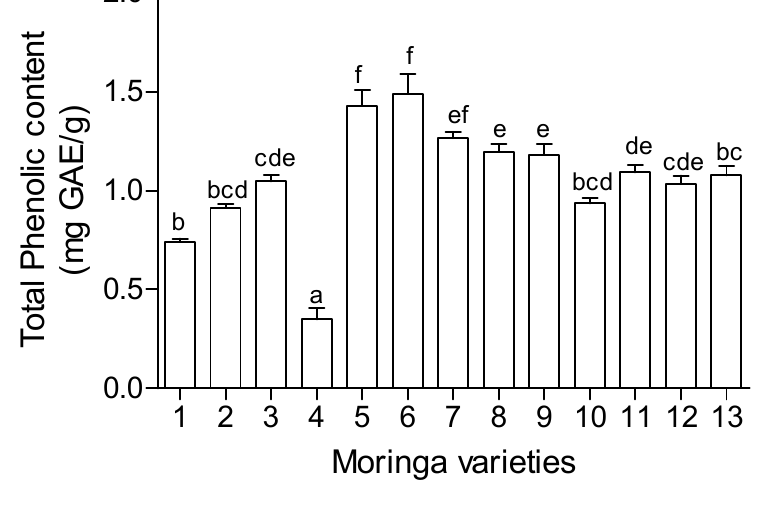
Figure 2. Total phenolic content of thirteen Moringa oleifera cultivars introduced from different geographical locations around the world. 1. TOT4880; 2. TOT4977; 3. TOT5077; 4. TOT5028; 5. TOT5169; 6. SH; 7. TOT4893; 8. CHM; 9. TOT5330; 10. TOT7266; 11. TOT4100; 12. TOT4951; 13. Limpopo. Values expressed as gallic acid equivalent (GAE) per gram of plant extracts. Mean values (±SE) on bar graphs with different letters are significantly different ( p < 0.05; n =